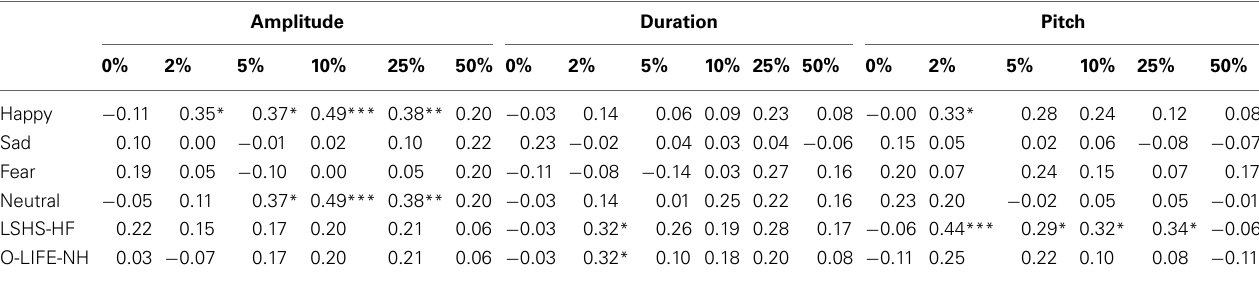
The correlation analysis was conducted on error rates for the four emotions and for each variable from the three TDTs. * p < 0.05; ** p < 0.01; *** p <